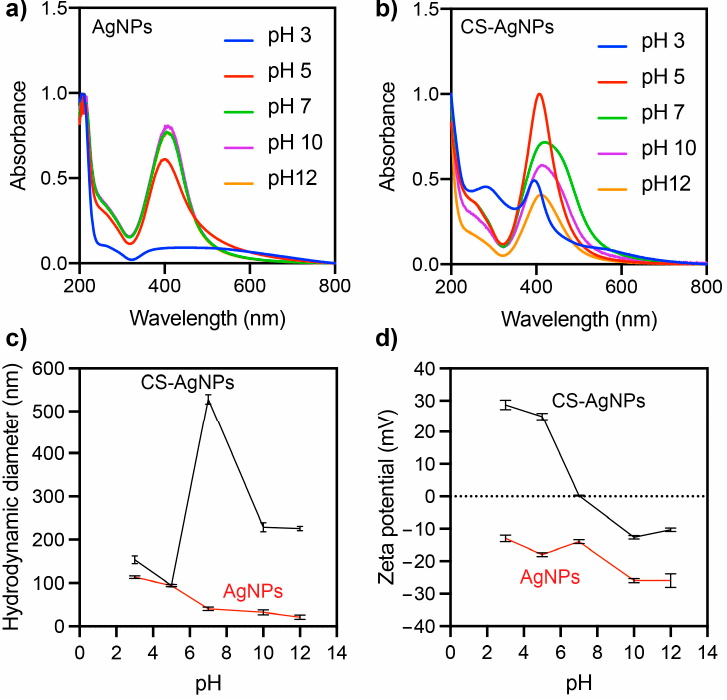
Figure 6. Effect of pH on the UV-vis ( a , b ), hydrodynamic diameter ( c ), and zeta potential ( d ) of synthesized Ag NPs and CS-Ag NPs. synthesized Ag NPs and CS-Ag